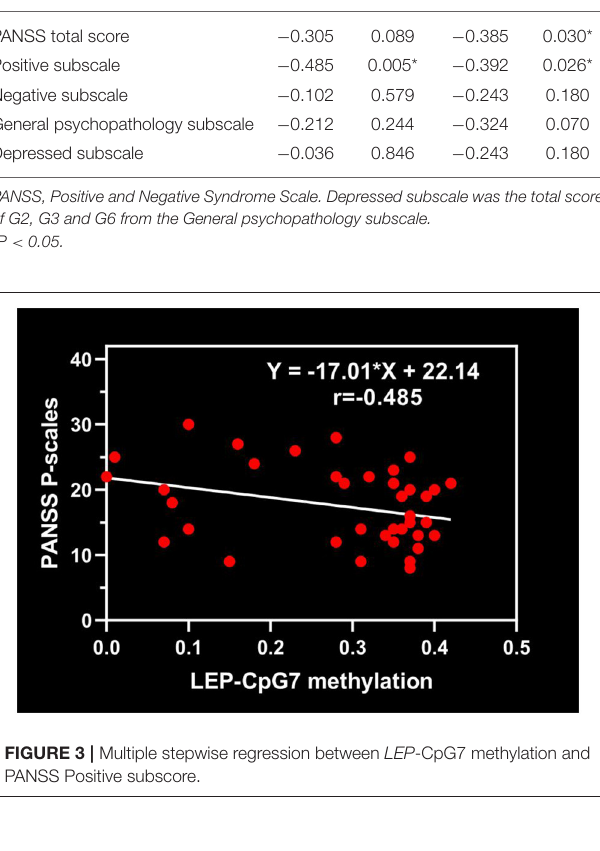
= − 17.071, t = − 2.170, P = 0.037). Meanwhile, LEP- mRNA expression was not significantly correlated with PANSS total score due to being excluded from the linear regression ( β = − 5.951, t = − 1.601, P = 0.118; Figure 3